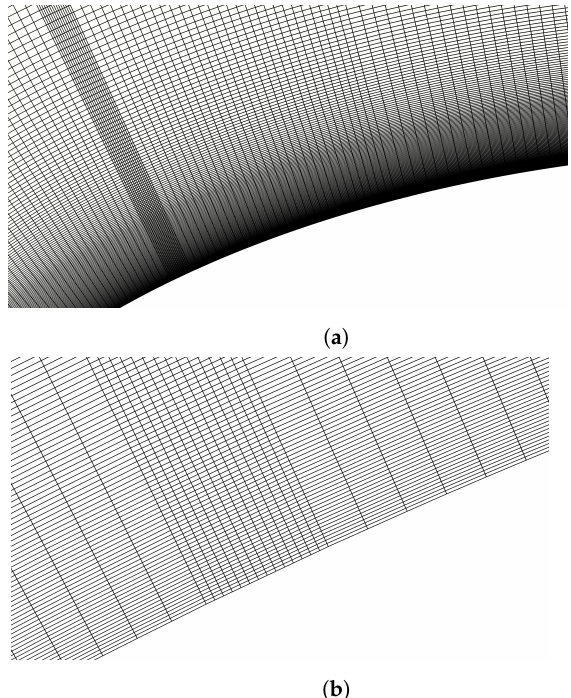
Figure 5. Mesh modification for the AFC jet implementation. ( a ) Close up view of the structured sub-mesh. ( b ) Close up view of the jet